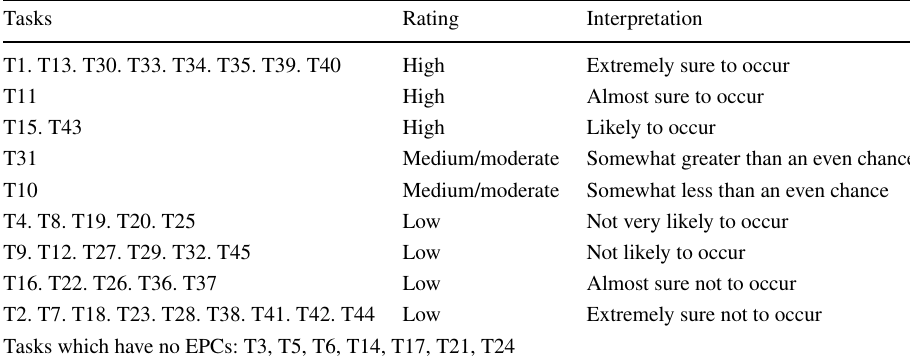
Table 9 Task-risk assessments for